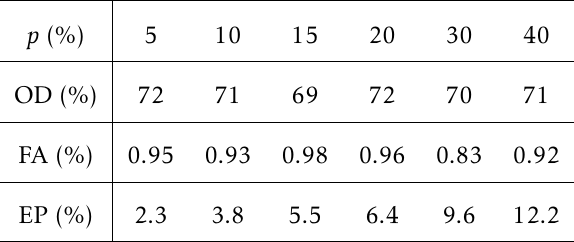
Table 4. The MD In [9] Based Simulation Result ( p Indicates Prior Error Probability), OD denotes Outlier Detection, FA denotes False Alarm and EP denotes Error